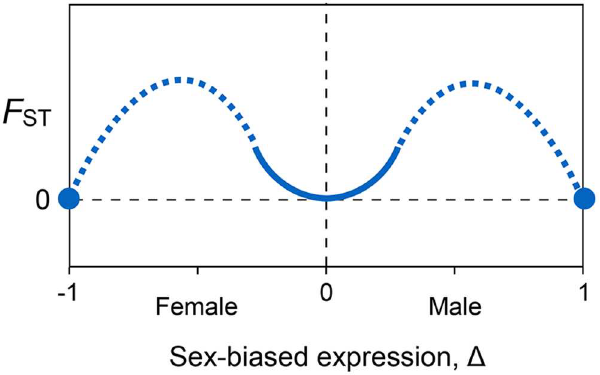
Fig 4. Qualitative conclusions from the geneticmodel. Geneticdivergence between the sexes, measured as F ST , is minimizedwhen gene expression is unbiased ( Δ = 0), then increases quadraticallyfor small degrees of female-biased and male-biased expression (solid curve). F ST is also 0 when expression is completely female-biased( Δ = –1) or male-biased ( Δ = 1) (solid circles).Values of F ST expected for intermediate sex-dependent expression are interpolated by eye